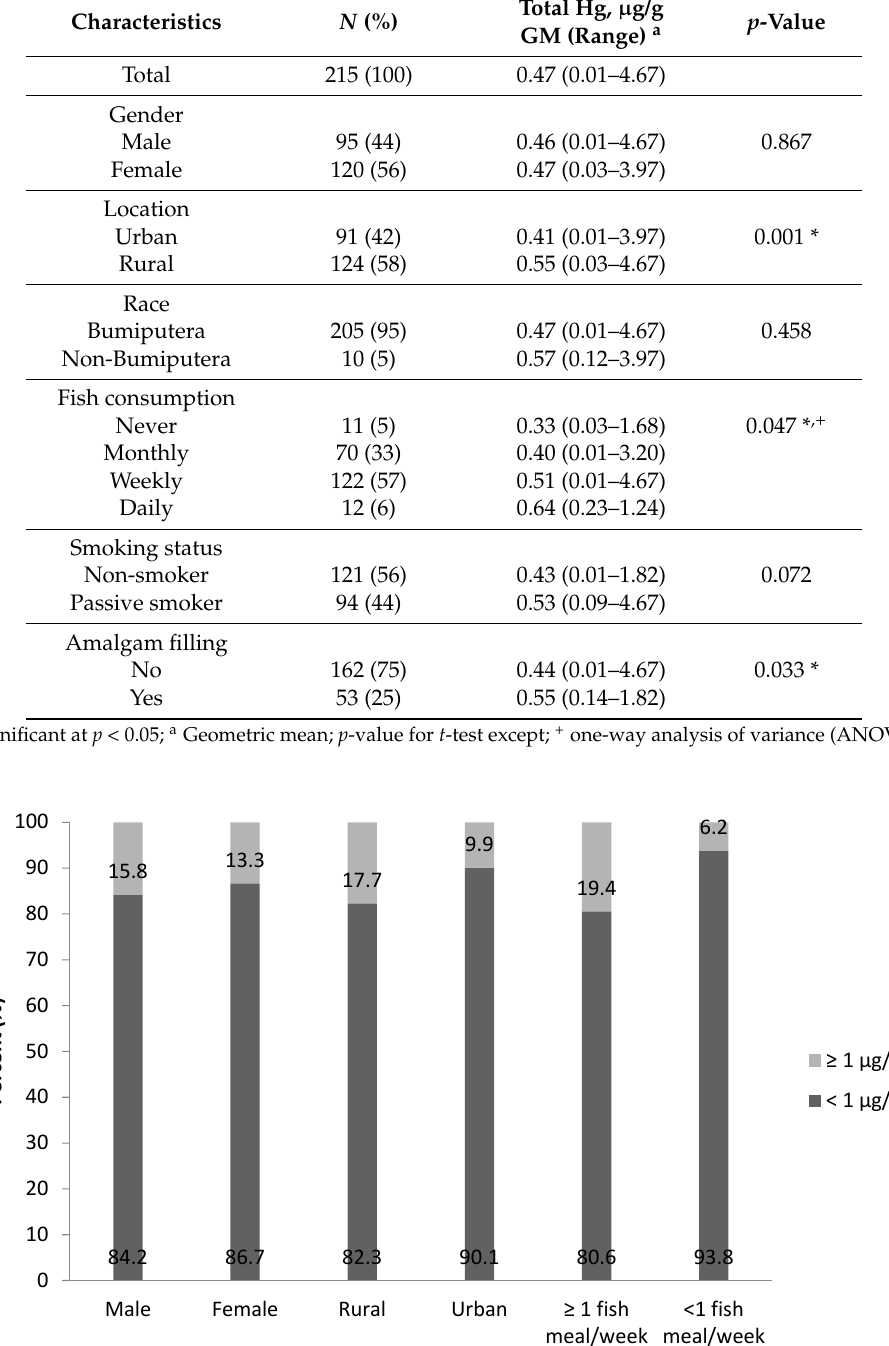
Figure 1. Mercury distribution among respondents according to gender, location and frequency of fish consumption of the study.